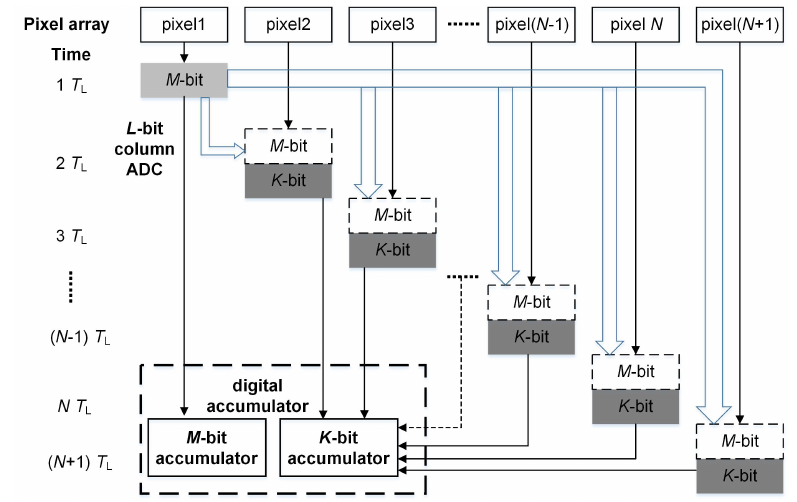
Figure 2. Low power digital domain accumulation